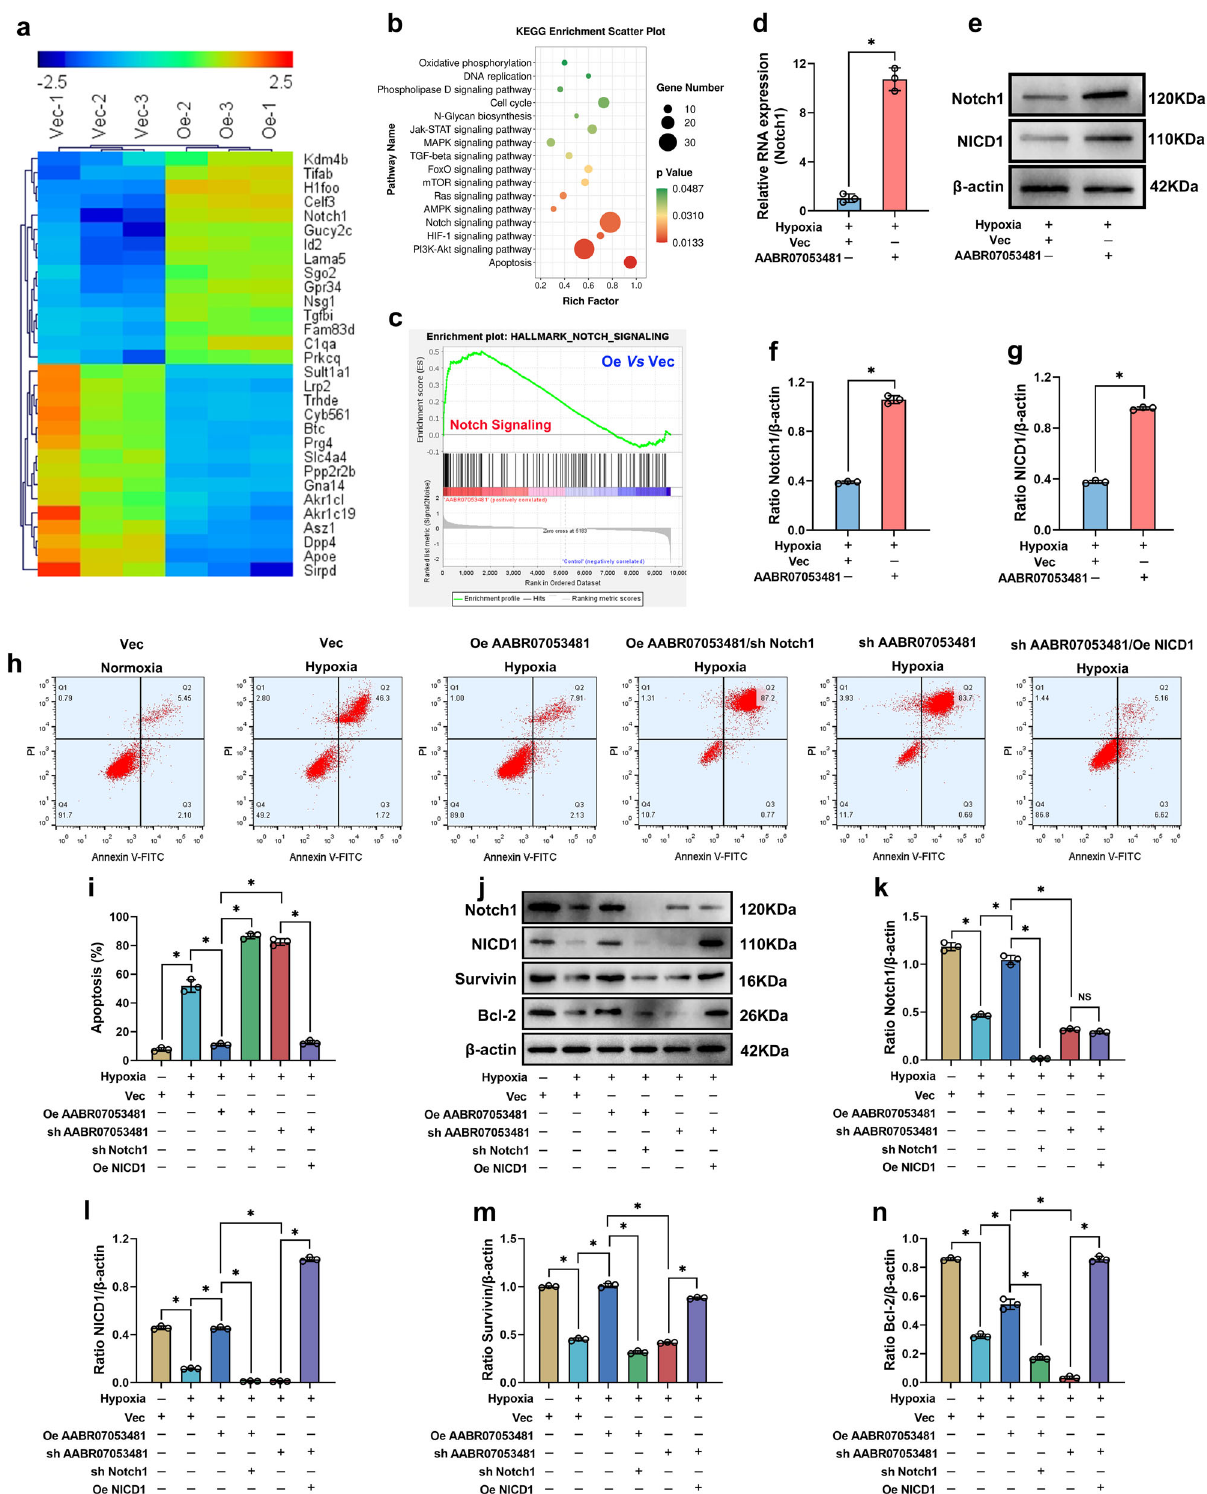
Fig. 3 LncAABR07053481 inhibits hypoxia-induced apoptosis of BMSCs by regulating the Notch1 pathway. a mRNA clustering analysis ( n = 3). b Kyoto Encyclopedia of Genes and Genomes (KEGG) pathway enrichment analysis of differentially expressed genes. c Gene set enrichment analysis (GSEA). d The expression of Notch1 was detected by qPCR ( n = 3). e – g The expression levels of Notch1 and NICD1 were detected by western blotting ( n = 3). h , i Detection of BMSC apoptosis by Annexin V-FITC/PI ( n = 3). j – n The expression levels of Notch1 , NICD1, Survivin, and Bcl-2 were detected by western blotting ( n = 3). Data were shown as mean ± SD. * P < 0.05; In ( d , f , g ), statistical signi fi cance was calculated by Student ’ s t -test; In ( i , k – n ), statistical signi fi cance was calculated by one-way ANOVA with Tukey ’ s post hoc